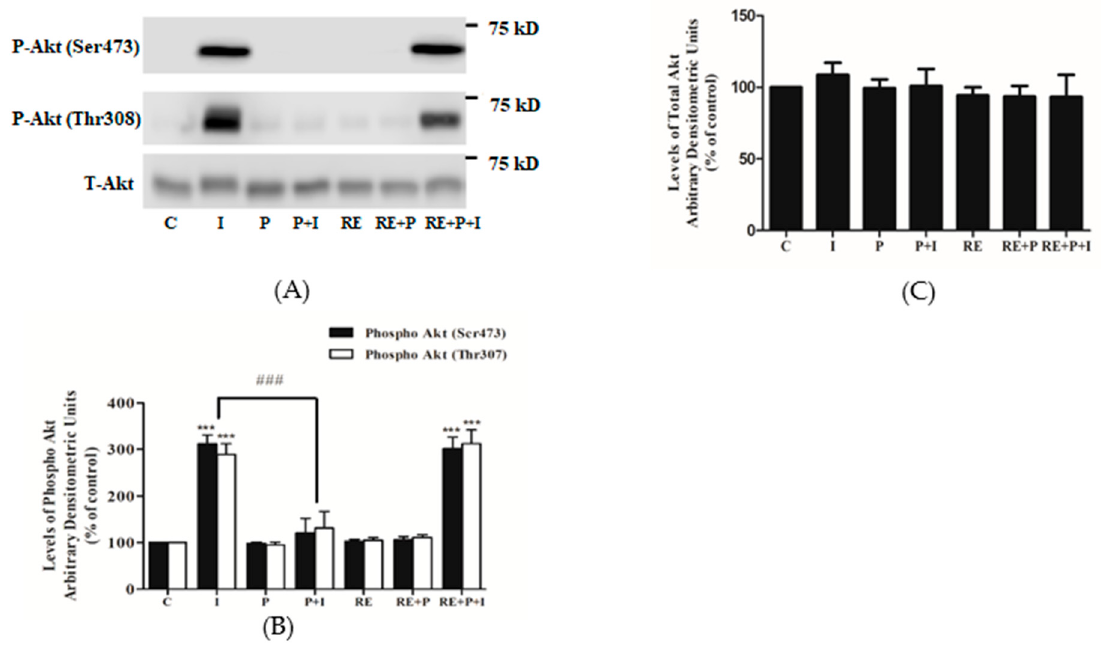
Figure 4. Effects of palmitate and RE on Akt expression and Ser473 and Thr308 phosphorylation. Fully differentiated L6 myotubes were treated without (control, C) or with 0.2 mM palmitate (P) for 16 h in the absence or the presence of 5 µ g/mL RE followed by stimulation without or with 100 nM insulin (I) for 15 min. After treatment, the cells were lysed, and SDS-PAGE was performed, followed by immunoblotting with specific antibodies that recognize phosphorylated Ser473, Thr308 or total Akt. Representative immunoblots are shown ( A ). The densitometry of the bands was measured and expressed in arbitrary units ( B , C ). The data are the mean ± SE of three separate experiments (*** p < 0.001 vs. control, ### p < 0.001 vs. insulin alone).